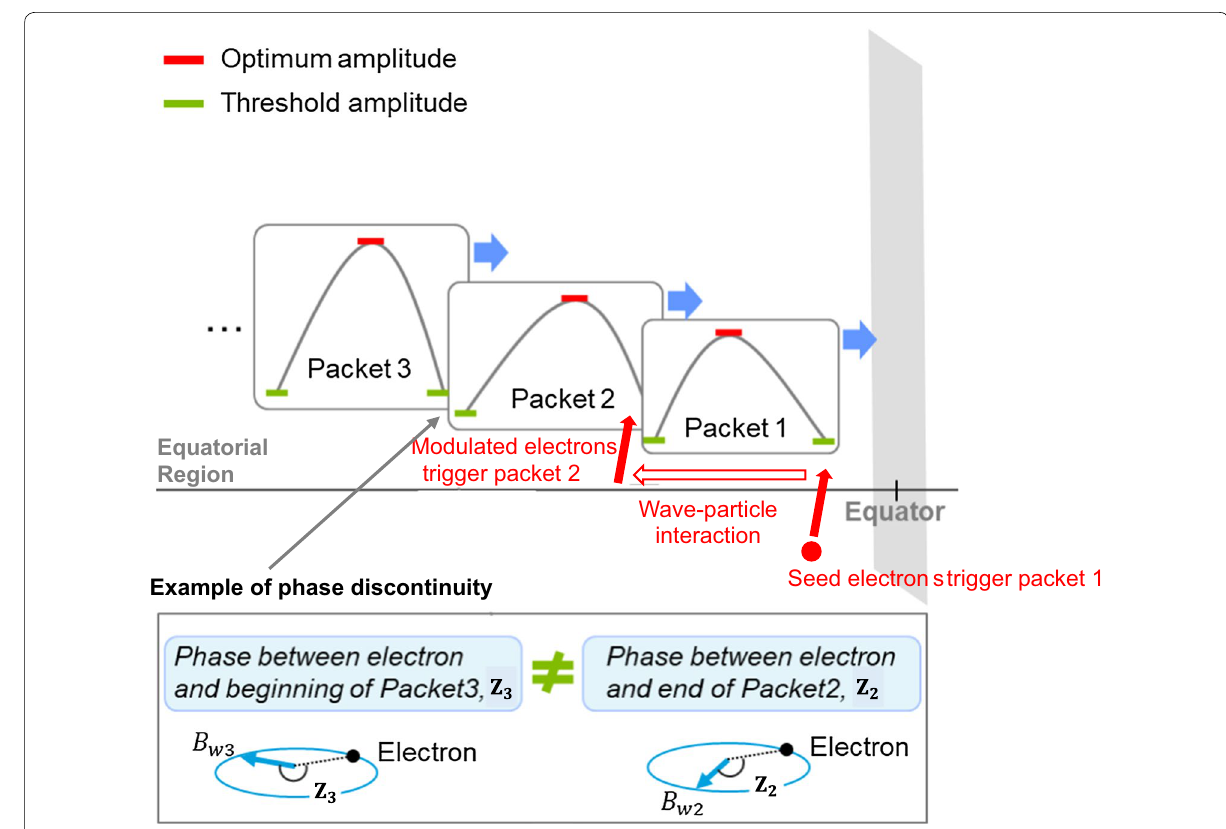
Fig. 3 Schematic diagram of generation process of subpackets in the equatorial region. Seed electrons generate a chorus wave subpacket (packet 1) by cyclotron resonance. The resonant seed electrons are modulated by packet 1 through the interaction. The frequency of packet 1 at the timing of releasing the seed electrons is transferred to packet 2 when the modulated seed electrons trigger packet 2. Since phase of each subpacket is randomized in the simulation, phase difference between packet 2 and the resonant seed electrons gyrophase Z 2 is discontinuously changed to Z 3 at the timing of being released by packet 2 and interacting with packet